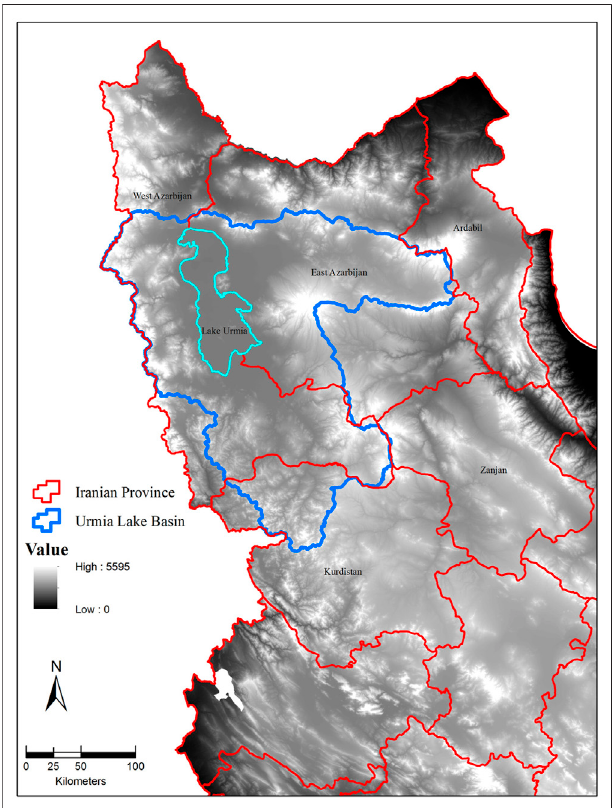
FIGURE 1 | Location of LU in Iran (author ’ s